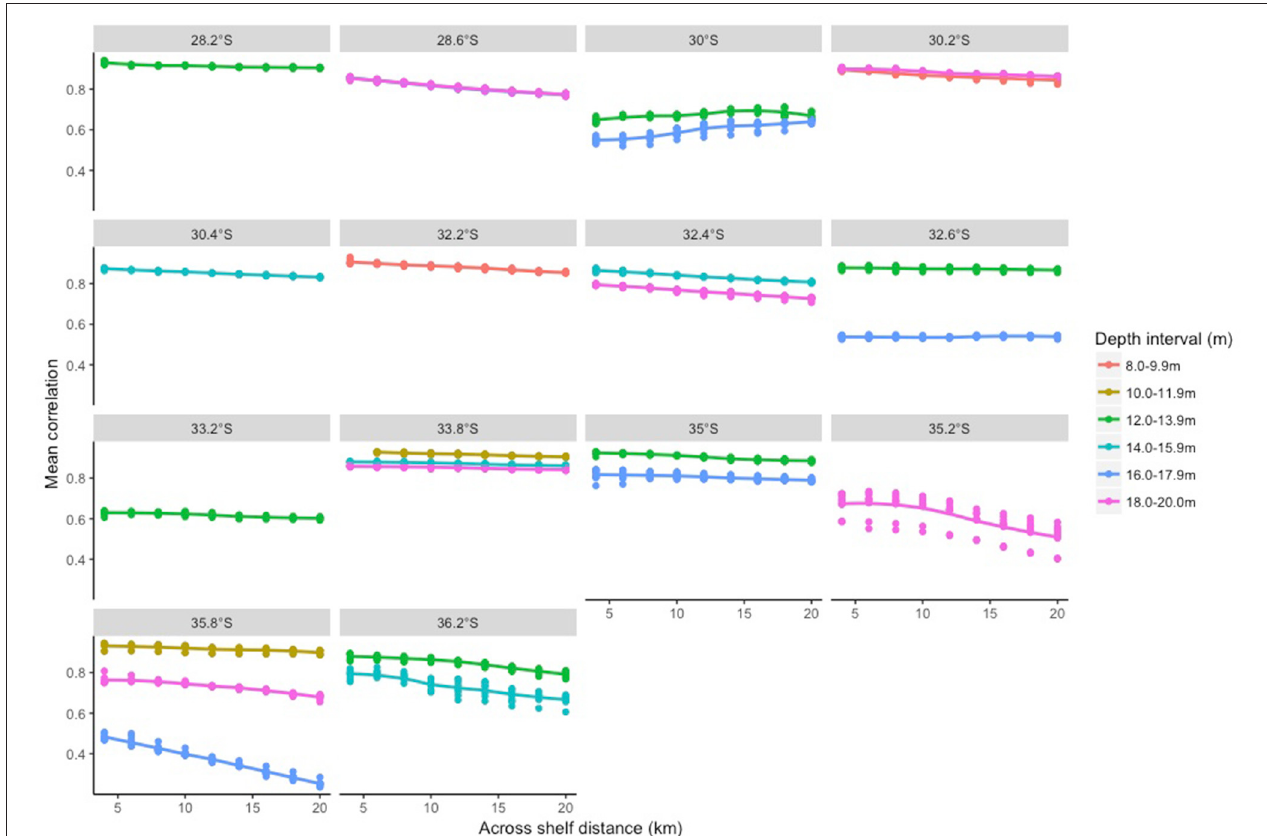
FIGURE 4 | Mean Pearson’s correlation between satellite data and in situ data for different across-shelf distances.